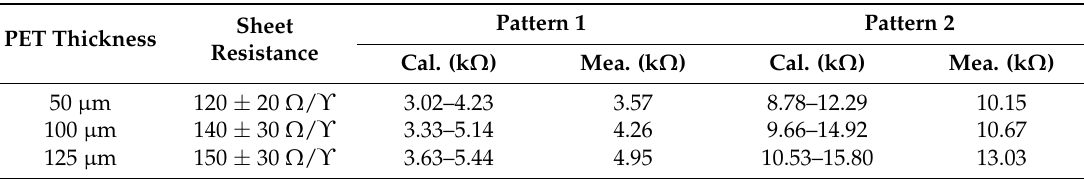
Table 1. List of sheet resistance, theoretical value, and measurement results of original and cut patterned ITO/PET sample.